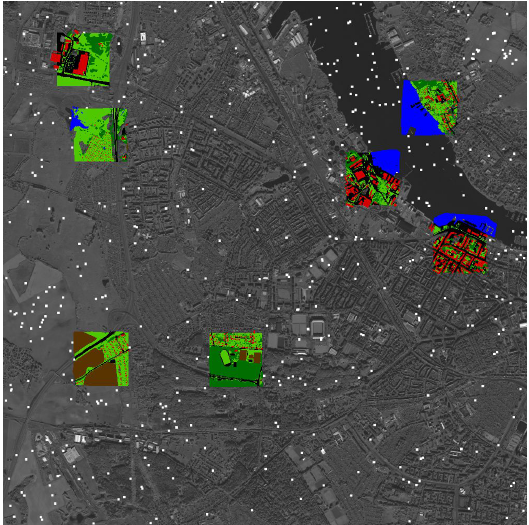
Figure 4: The seven training regions and the 65 evaluation points per